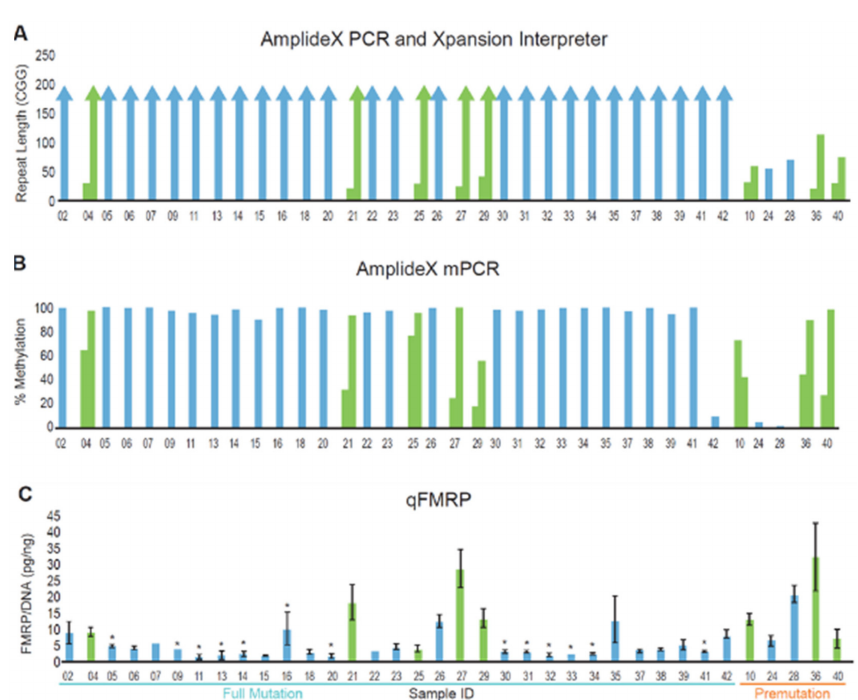
Figure 2. ( A ) FMR1 genotype (top panel) and ( B ) methylation status (middle panel) correlated with ( C ) FMRP levels (lower panel). Samples were annotated for FMR1 CGG repeat length and degree of methylation using AmplideX PCR / CE FMR1 and mPCR technologies. Male and female samples are colored in blue and green, respectively. Bottom panel: Error bars represent standard deviations. FM samples without methylation mosaicism are indicated with an asterisk above the bar.